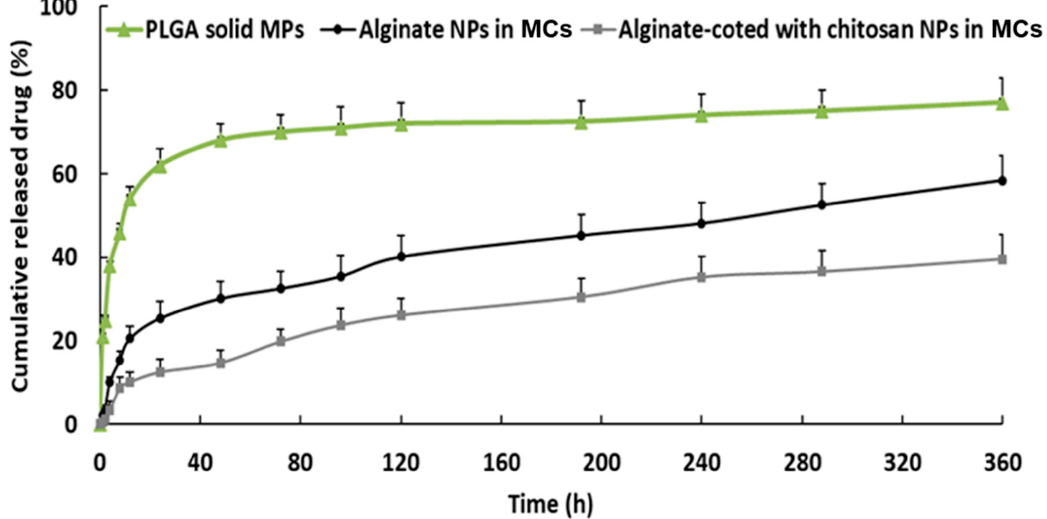
Figure 5. The cumulative release profile of MET from PLGA MPs, alginate NPs in MCs, and alginate coated with chitosan NPs in MCs ( n = 3, mean ± SD).